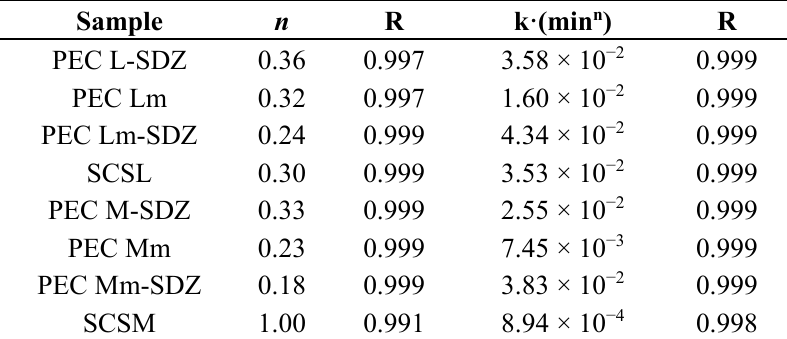
Table 4. Kinetic parameters for sulfadiazine (SDZ)